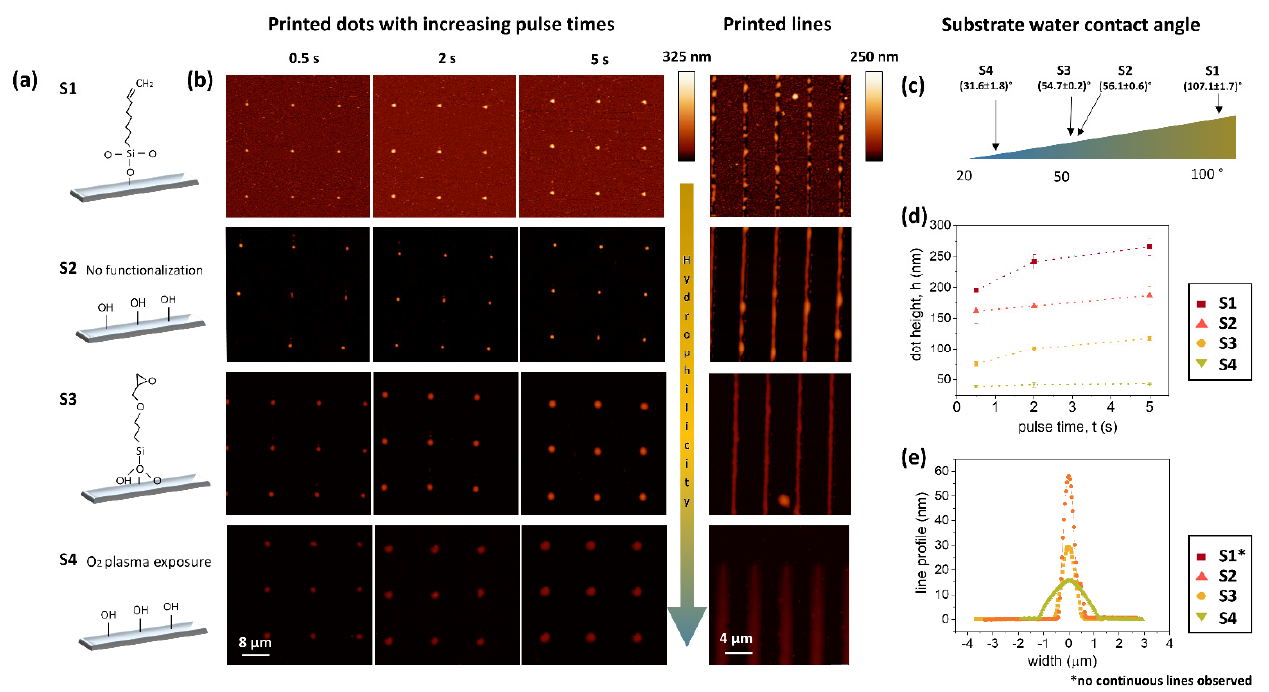
Figure 3. Influence of substrate wettability and chemistry on patterning. ( a ) Scheme of respective sample surface chemistry. ( b ) AFM images of polymer nanodots (left) and lines (right) patterned (right) on the functionalized substrates, showing increasing hydrophilicity from top to bottom (indicated by the arrow), written with the same working parameters. ( c ) Measured water contact angle for the different substrates. ( d ) Dot height on the different substrates as a function of the contact time. ( e ) Average line profiles showing different spreading behavior depending on the substrate functionalization.